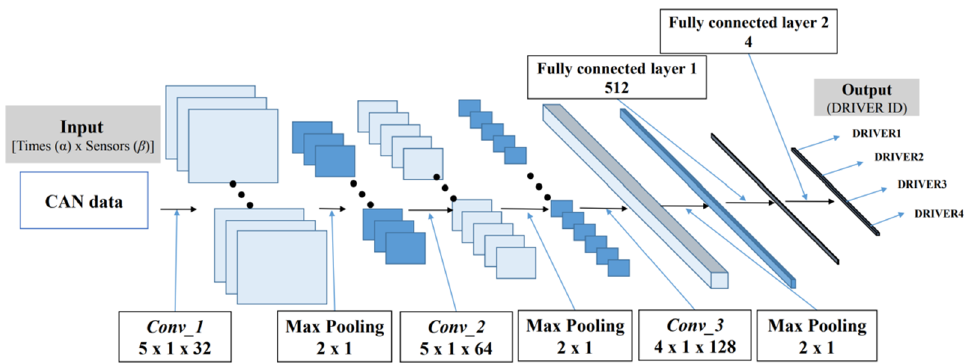
Figure 6. CNN structure, adopted from [65].